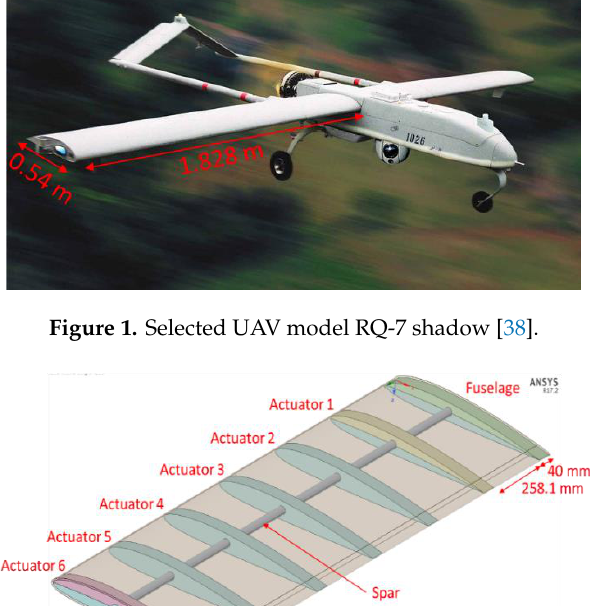
Figure 1. Selected UAV model RQ-7 shadow [38]. Table 1. Detail Specifications of RQ-7, Aircraft Model for Study.